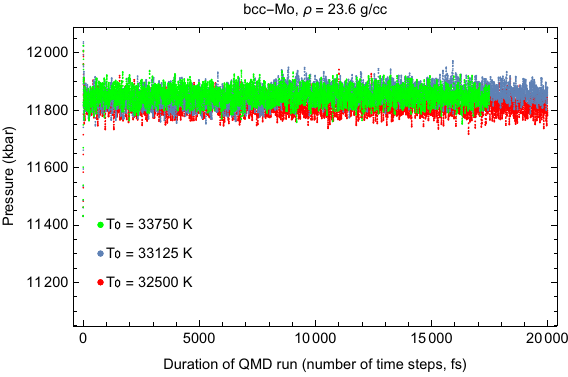
Figure 4. The same as in Figure 2 for